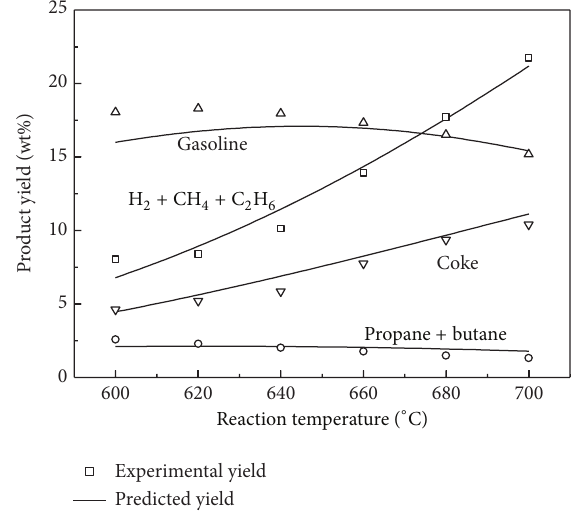
Figure 5: Predicted and experimental product lump yields as a function of reaction temperature (catalytic pyrolysis of HAGO, catalyst-to-oil weight ratio of 16.7, weight hourly space velocity of 4.87 h −1 , and steam-to-oil weight ratio of